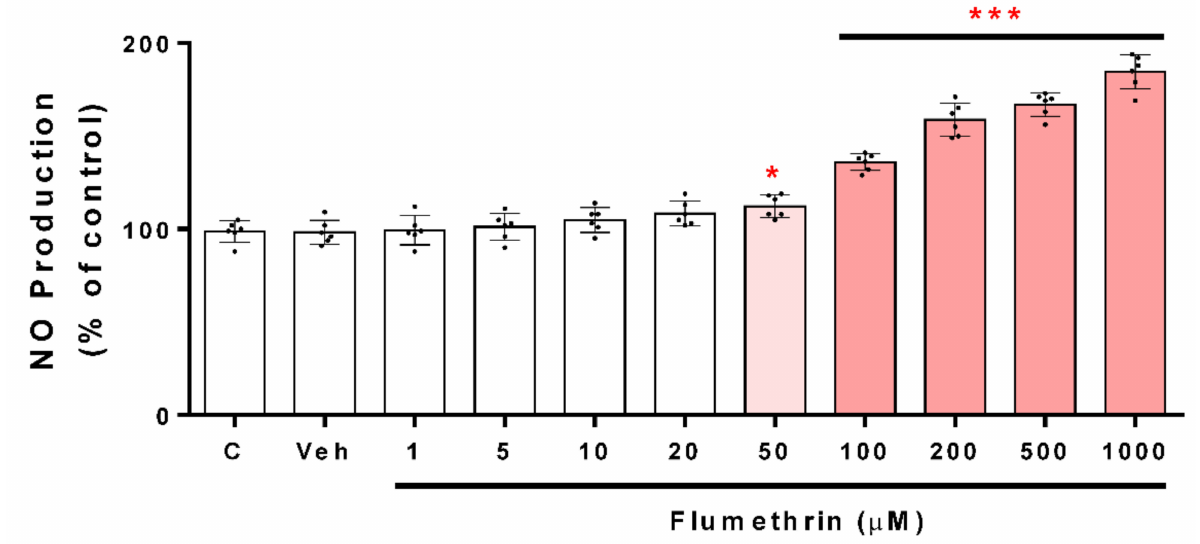
Figure 3. The NO production induced by flumethrin (1–1000 µ M) in SH-SY5Y cells after a 24 h incubation period. Data was normalized as % control. DMEM-treated cells with 1% FBS were the positive control (c), and cells with 0.1% DMSO were the negative control (Veh). Results are presented as the mean ± SD of six replicates. * p < 0.05, *** p < 0.001 compared to